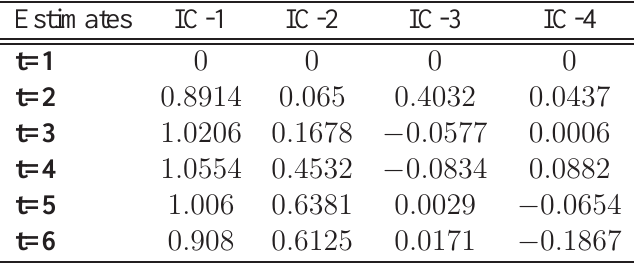
Table 2: Estimated Mixing Matrix with 4